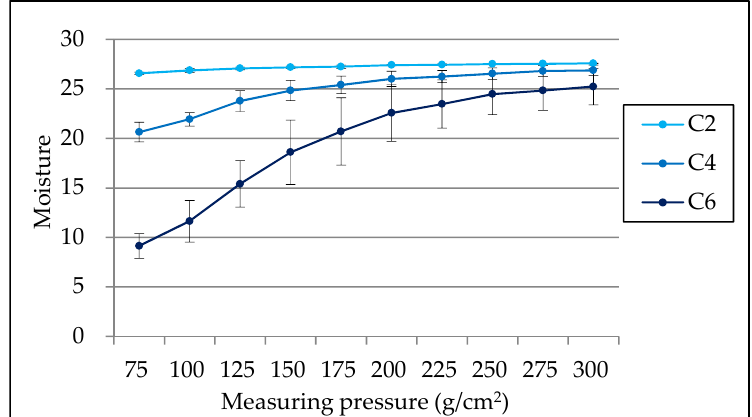
Figure 4. Mean value and standard deviation of agar moisture at each measuring pressure. C2: 2% agar, C4: 4% agar, C6: 6% agar.